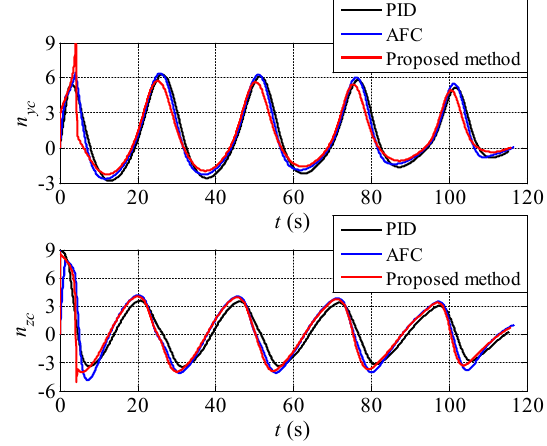
Figure 16. The actual control overloads of the UCAV during the process of attack